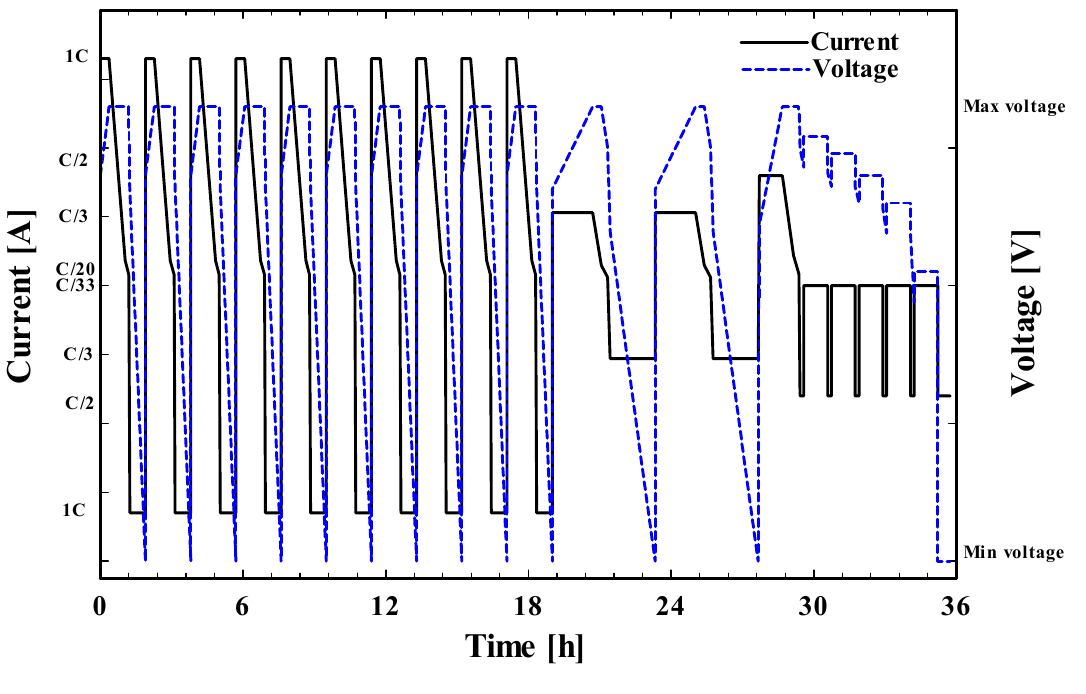
Figure 6. The accelerated ageing profile and RTP test for degradation analysis of the Nissan Leaf second life battery.